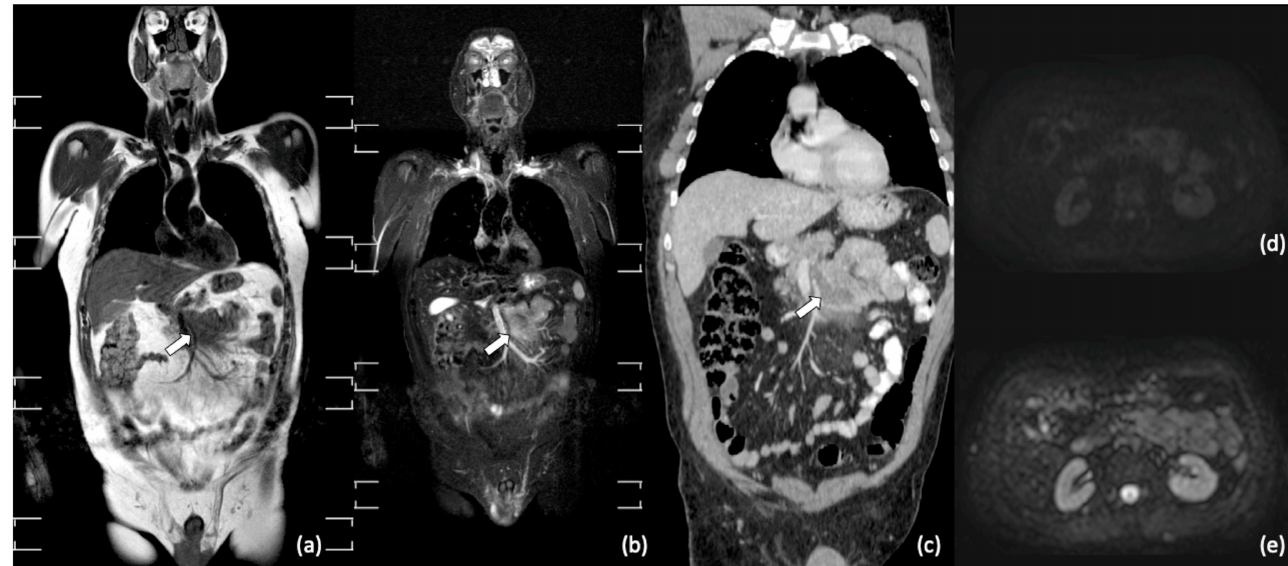
Figure 3. Whole-body MRI and contrast enhanced CT after chemotherapy treatment of a 46-year-old man with Follicular Lymphoma. Coronal T1-weighted ( a ); coronal short tau inversion recovery (STIR) ( b ); coronal MPR CT portal phase( c ); axial